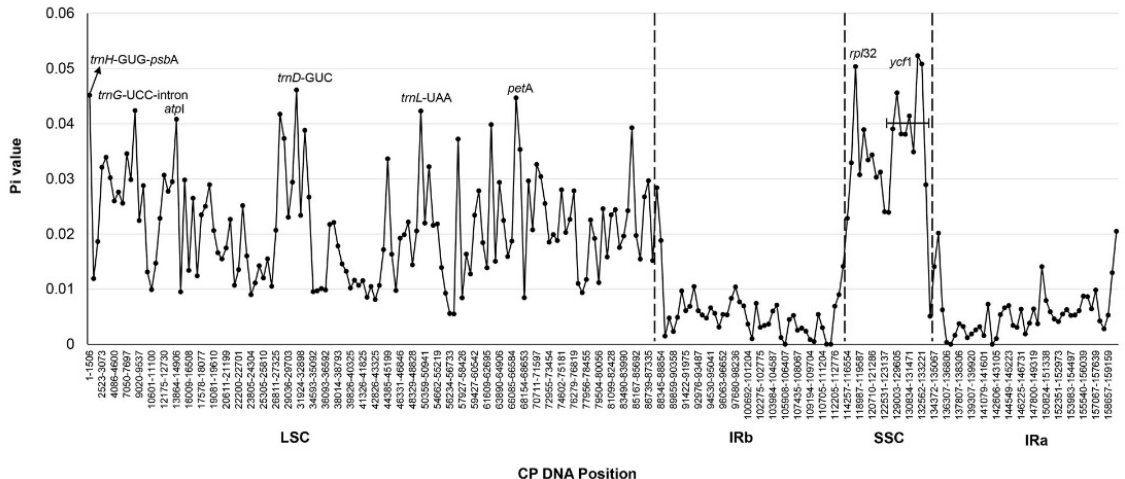
Fig. 5: Nucleotide diversity (Pi) of chloroplast genome among the Gentiana species. Each black dot represents the nucleotide diversity per 500 bp. LSC: large single-copy region; SSC: small single-copy region; IRa and IRb: inverted repeats.